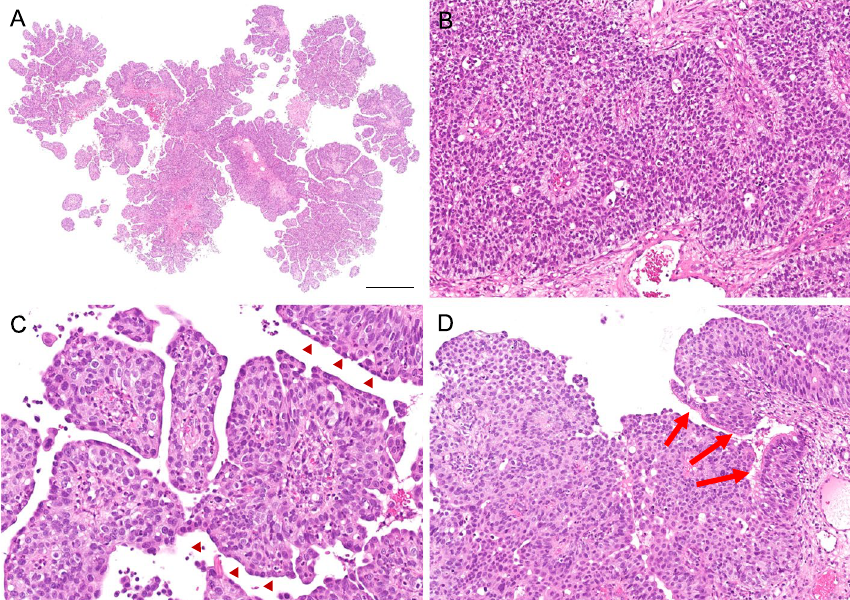
Fig. 2 Microscopic findings. A The tumor was composed of exophytic, papillary growth of multilayered epithelium. Scale bar 1 mm. B A palisading pattern of columnar cells with reverse polarity was observed in the basal layer. C The tumor cells were composed of uniformly round and polygonal cells with abundant, eosinophilic cytoplasm and monomorphic round nuclei with fine chromatin. Discontinuous flattened cells were found in the outermost layer of multilayered epithelium (arrowheads). D Focal ciliated epithelium from residual respiratory mucosa was found (arrows) while no dysplasia-carcinoma sequence was observed